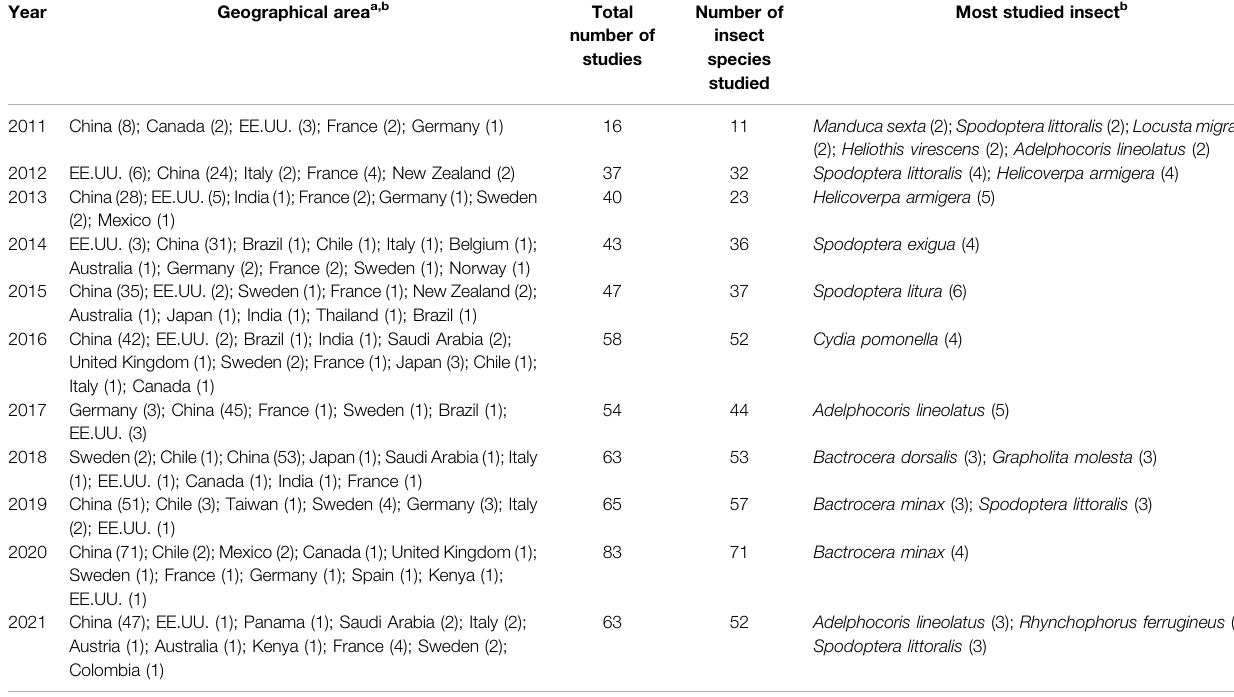
TABLE 2 | Summary of insect olfaction studies in the last